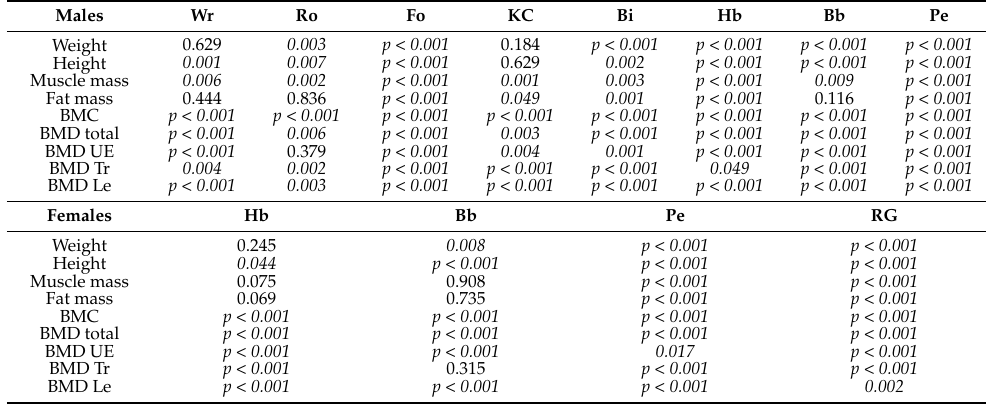
Figure 1. Z profile (mean of z-scores) of structural parameters in male athletes; BMC in grams and fat and muscle mass in kilograms were expressed as a percentage of height in meters. Table 3. Significance level of the Wilcoxon signed-rank tests (significant values in italics) of z-scores for components of body mass and for bone parameters in young athletes by